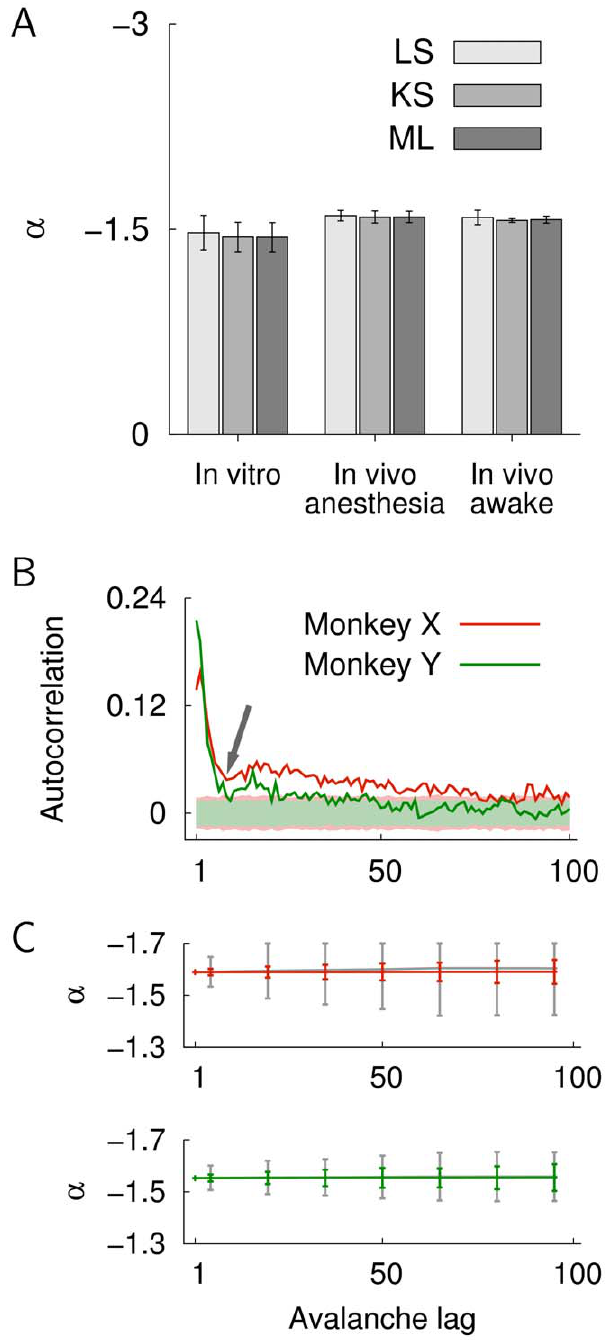
Figure 3. Estimation of slope parameter a for the in vitro data ( n =7 cultures), the in vivo data under anesthesia ( n =7), and the in vivo recordings in awake monkeys ( n =2). A. Shown are the average slope parameters a and the standard deviations (error bars). The three different estimation methods are: LS least-square estimation with logarithmic binning, KS Kolmogorov-Smirnov statistic, and ML maximum likelihood estimation (see Materials and Methods ). Estimated values of a were not statistically different: in vitro, F(2,18)=0.19, p =0.827; in vivo (anesthesia), F(2,18)=0.124, p =0.884; in vivo (awake), F(2,3)=0.21, p =0.821 (one-way ANOVA). Values of a were estimated for the entire range of cluster sizes, i.e., from avalanches that included only one electrode to clusters that spanned the entire multielectrode array. B. Autocorrelation of the avalanche sizes for monkey X and Y as a function of the avalanche lag. The autocorrelation showed a fast